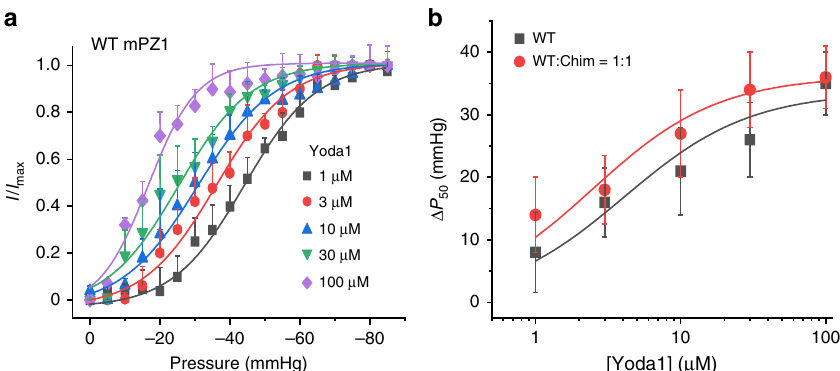
Fig. 7 Modulation of P 50 by varying Yoda1 concentrations. a Normalized peak current obtained using cell-attached pressure-clamp measurements in HEK 293T cells transfected with WT mPZ1 channels and plotted as a function of the pressure pulse for the indicated Yoda1 concentrations in the patch pipette ( V = − 80 mV). b Plots showing the shift of P 50 values ( Δ P 50 ) as a function of the Yoda1 concentration measured in cells transfected with WT mPZ1 (dark gray) or with the WT:Chim = 1:1 ratio (red). The dark gray and red lines are a fi t to the data using a standard binding equation similar to Eq. 2. In a and b , the plots correspond to an average of four independent experiments and error bars =